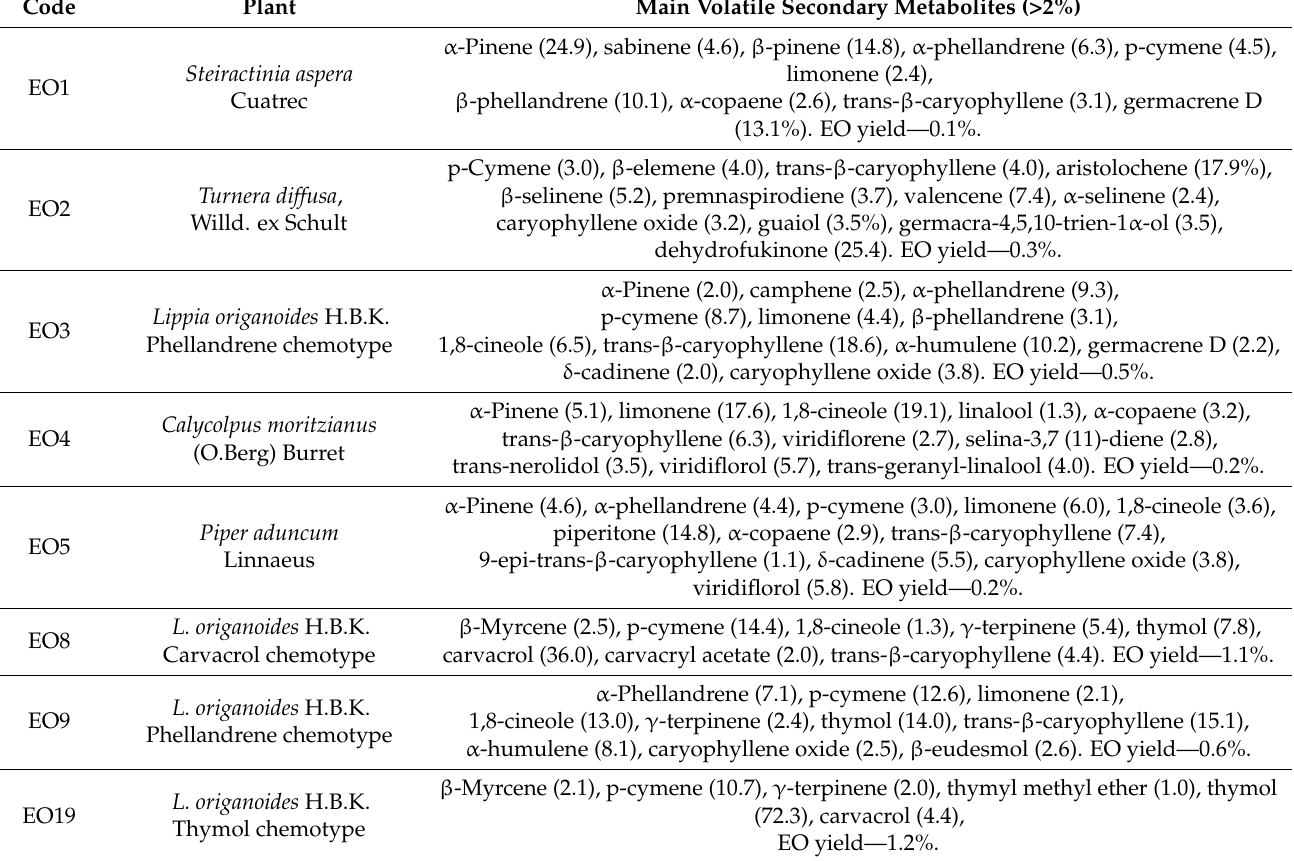
Table 1. Relative amounts (%) of the main compounds in the essential oils